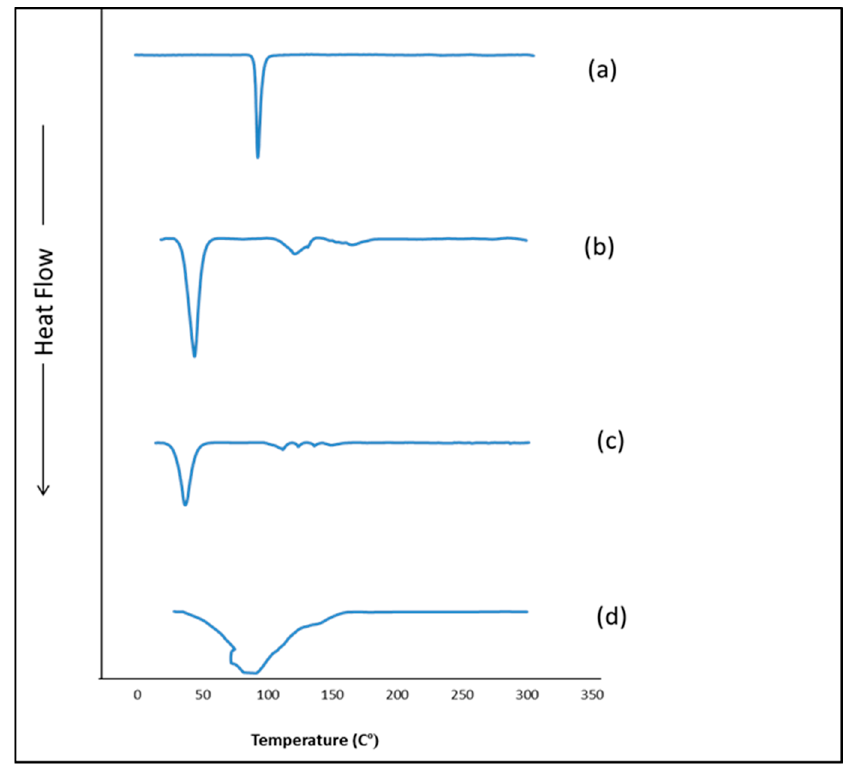
Figure 7. DSC thermograms of ( a ) TOL, ( b ) Span 60, ( c ) physical mixture of TOL-cosolvent spanlastics components, and ( d ) formula MS6.